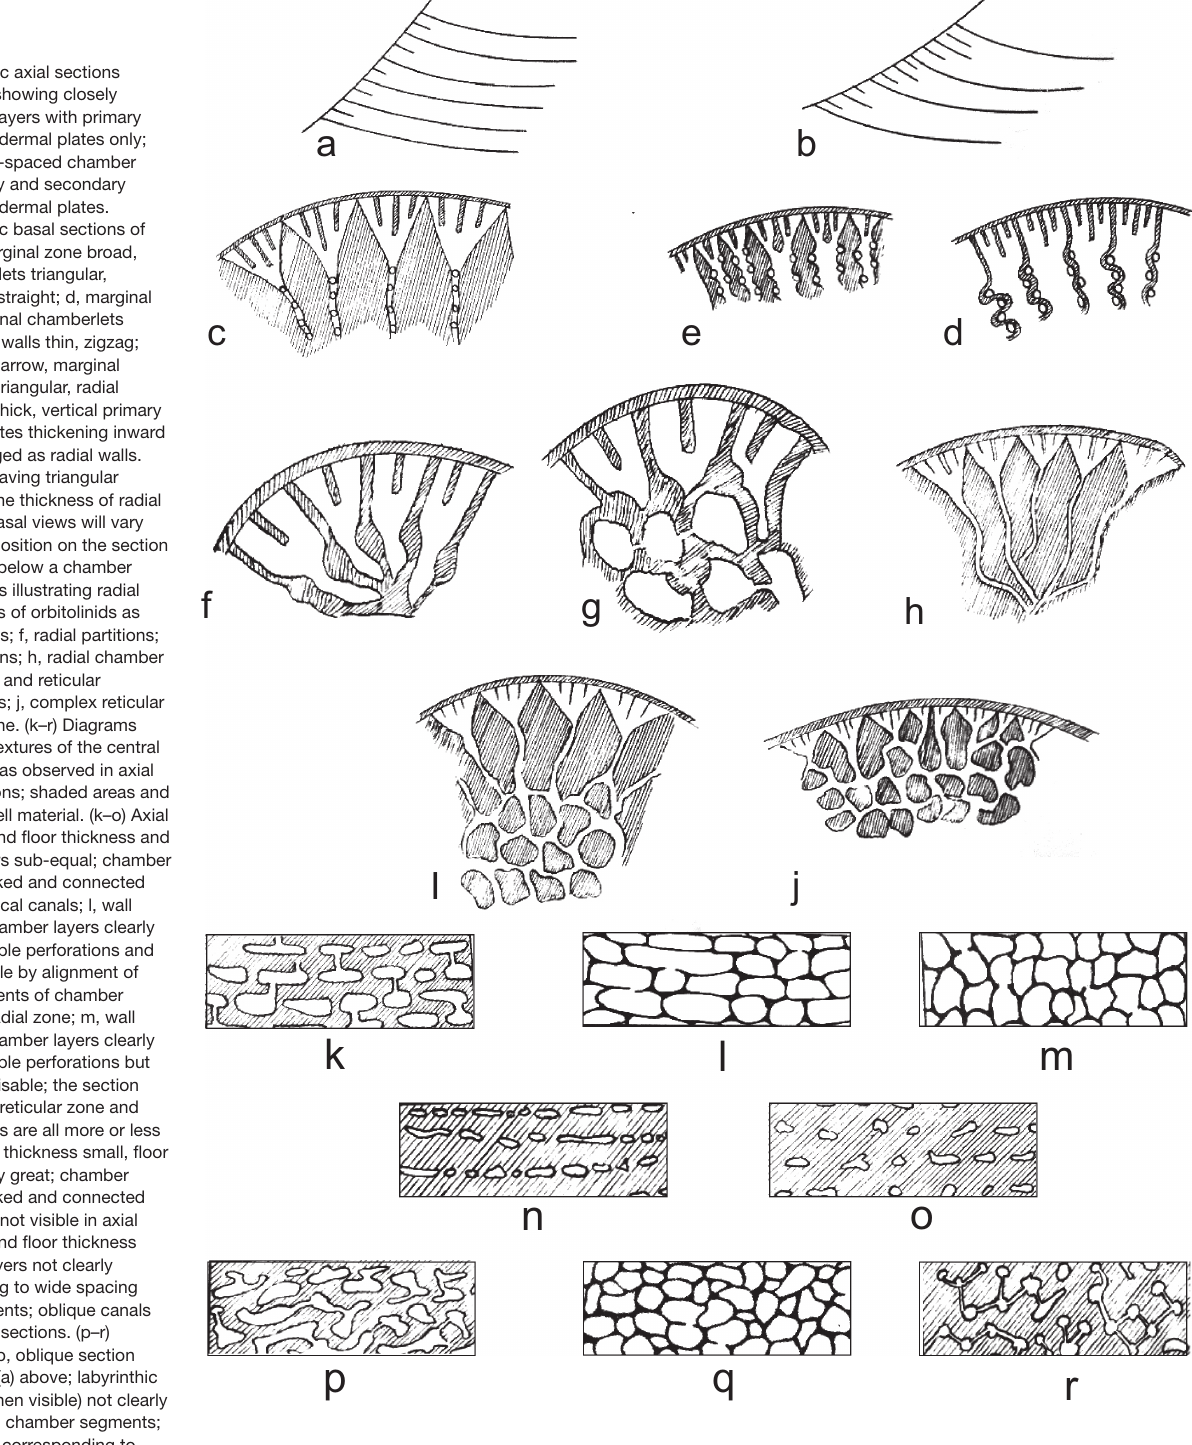
Figure 9 (a–b) Diagrammatic axial sections of orbitolinids; a, showing closely spaced chamber layers with primary horizontal sub-epidermal plates only; b, showing widely-spaced chamber layers with primary and secondary horizontal sub-epidermal plates. (c–e) Diagrammatic basal sections of orbitolinids; c, marginal zone broad, marginal chamberlets triangular, radial walls thick, straight; d, marginal zone broad, marginal chamberlets rectangular, radial walls thin, zigzag; e, marginal zone narrow, marginal chamberlets sub-triangular, radial walls moderately thick, vertical primary sub-epidermal plates thickening inward with some prolonged as radial